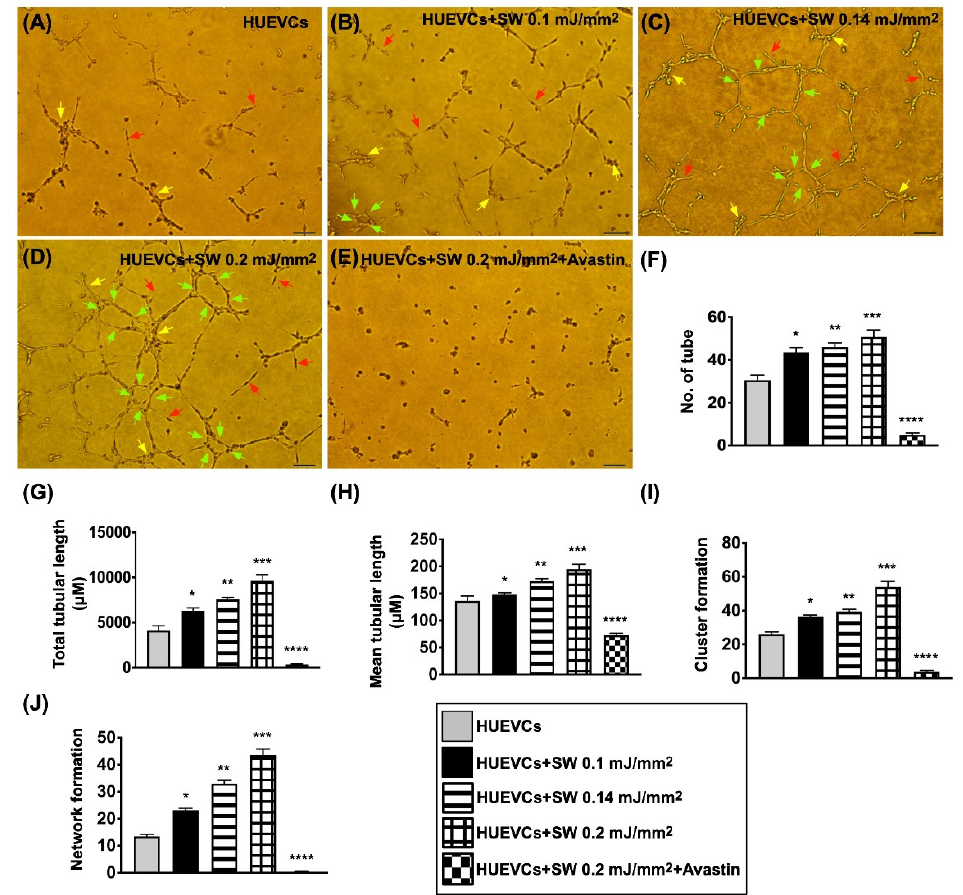
Figure 1. Impact of stepwise increased ECSW energy and Avastin on angiogenesis. ( A – E ) Illustrating the morphological features of Matrigel assay for identification of stepwise increase in ECSW energy on enhancing angiogenesis in human umbilical vein endothelial cells (HUVECs). The parameters of angiogenesis, including: (1) tubular formation (red arrows), (2) cluster formation (yellow arrows) and (3) network formation (green color). ( F – J ) Statistical analysis for angiogenesis parameters (F: number of tubules; G: total tubular length; H: mean tubular length; I: cluster formation; J: network formation). “*” represents in comparison with the control, * for p < 0.05, ** for p < 0.01, *** for p < 0.001, **** for p < 0.0001. Scale bar in right lower corner represents 50 µ M. n = 6 for each group. HUVECs = human umbilical vein endothelial cells; SW = shock wave.